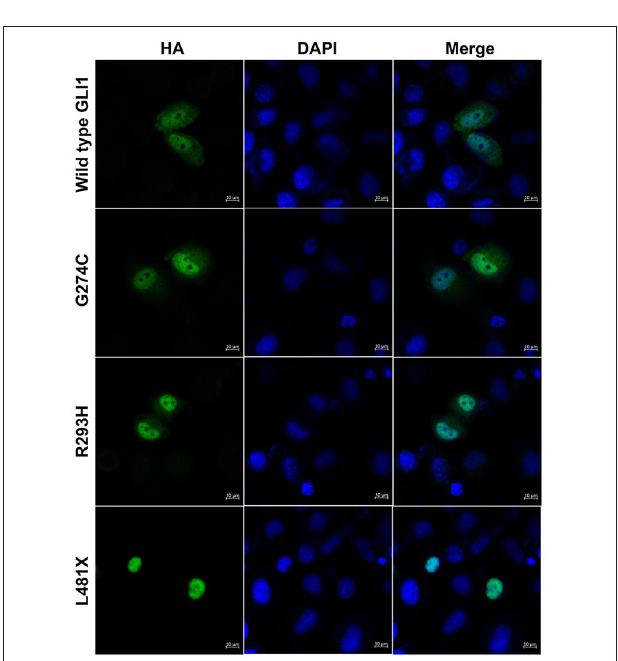
FIGURE 4 | GLI1 p.L481X affect protein subcellular localization. HeLa cells were transfected with HA-tagged wild-type or mutant GLI1 expression constructs. Immunofluorescence was performed using anti-HA antibody (Green). Nuclei were counterstained with Hoechst (Blue). Scale bars are 10 µ